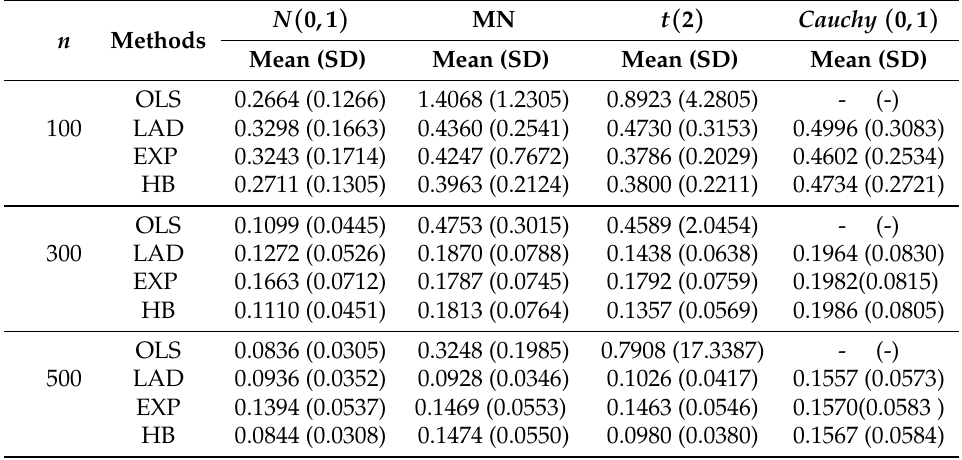
Table 2. The mean (SD) of IMSE 1 for ˆ β ( t ) under different error distributions and sample